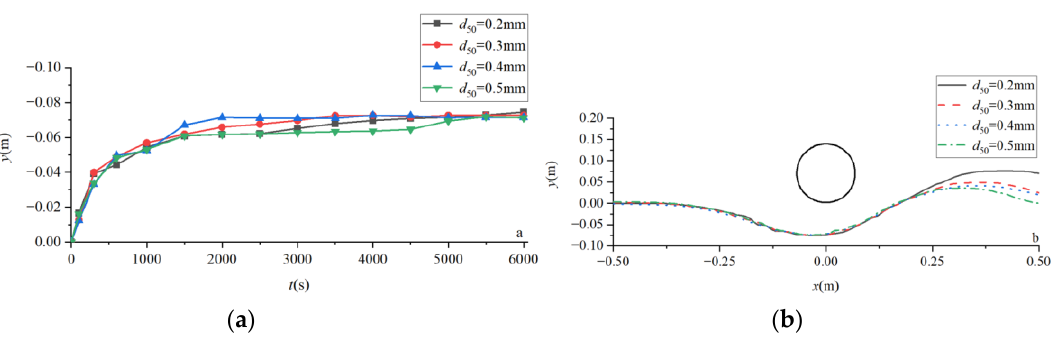
Figure 9. Comparisons of scour depth and terrain under the pipeline for different sediment mean diameters. ( a ) The scour depth and ( b ) The scour terrain. diameters. ( a ) The scour depth and ( b ) The scour